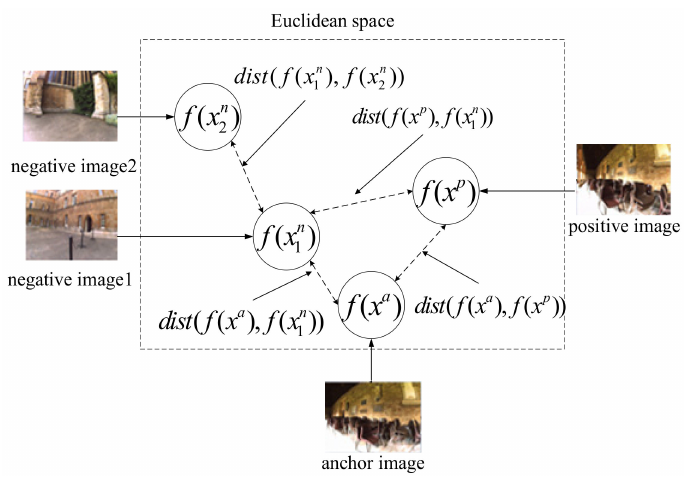
Figure 2. The possibly anomalous distance relationship caused by the triplet